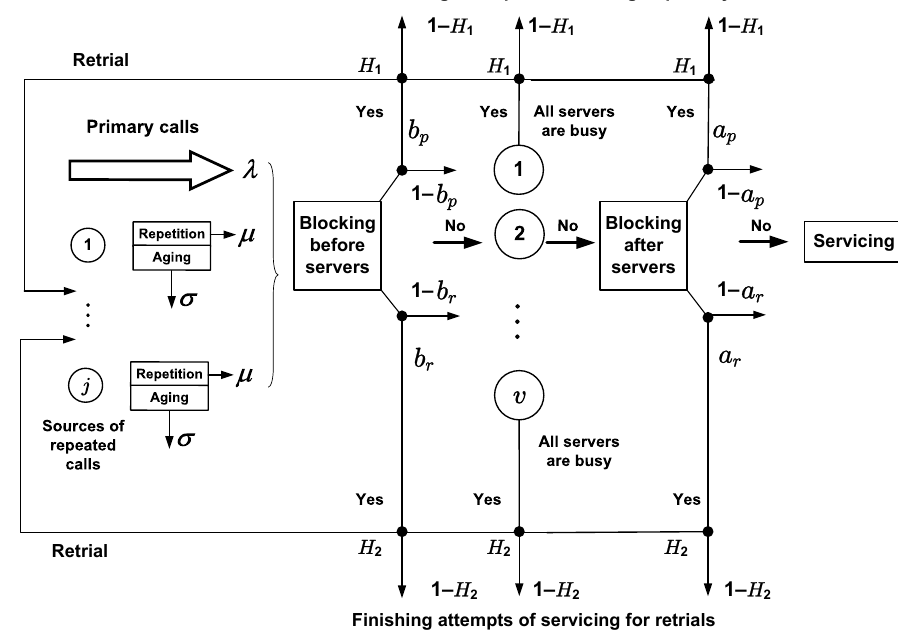
Figure 2. Functional model of the generalized system with blocked call